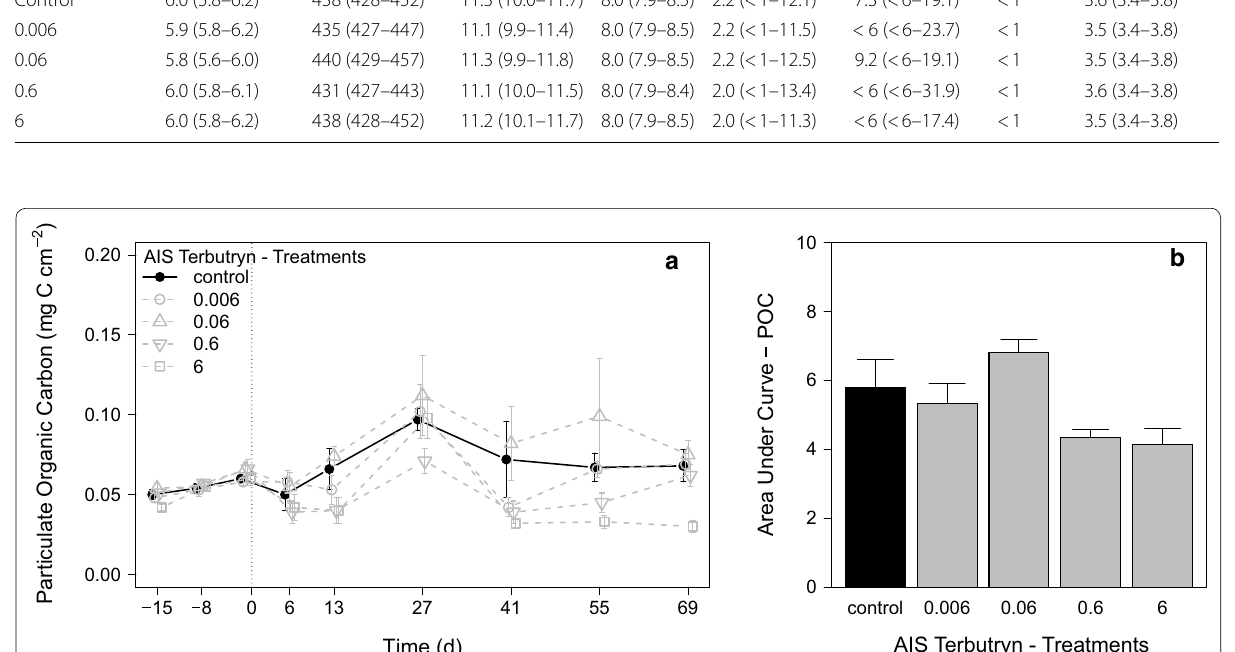
Fig. 2 a Development of aufwuchs POC during the terbutryn experiment in the different treatments [mean treatments in µg L −